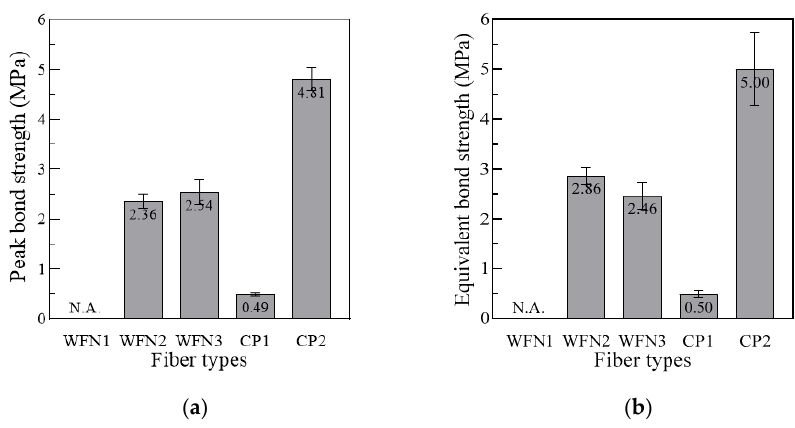
Figure 8. Effect of the different fibers on the: ( a ) Peak bond strength and ( b ) Equivalent bond strength.